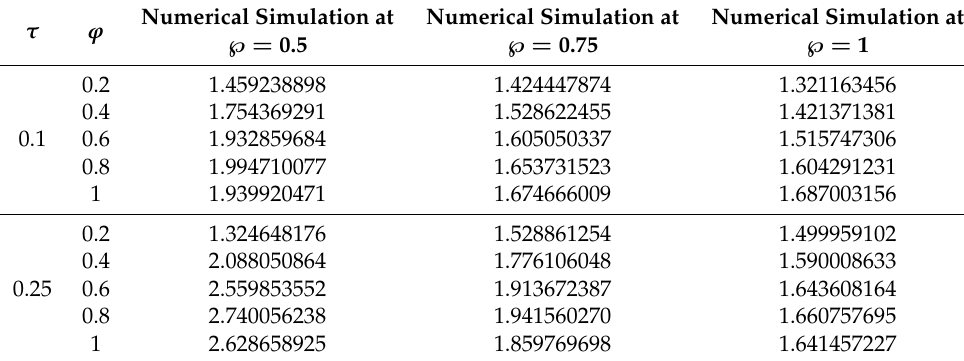
Table 4. Numerical analysis of v ( ϕ , τ ) of the example given in 2 with different values of ϕ , τ , and p = 2 3